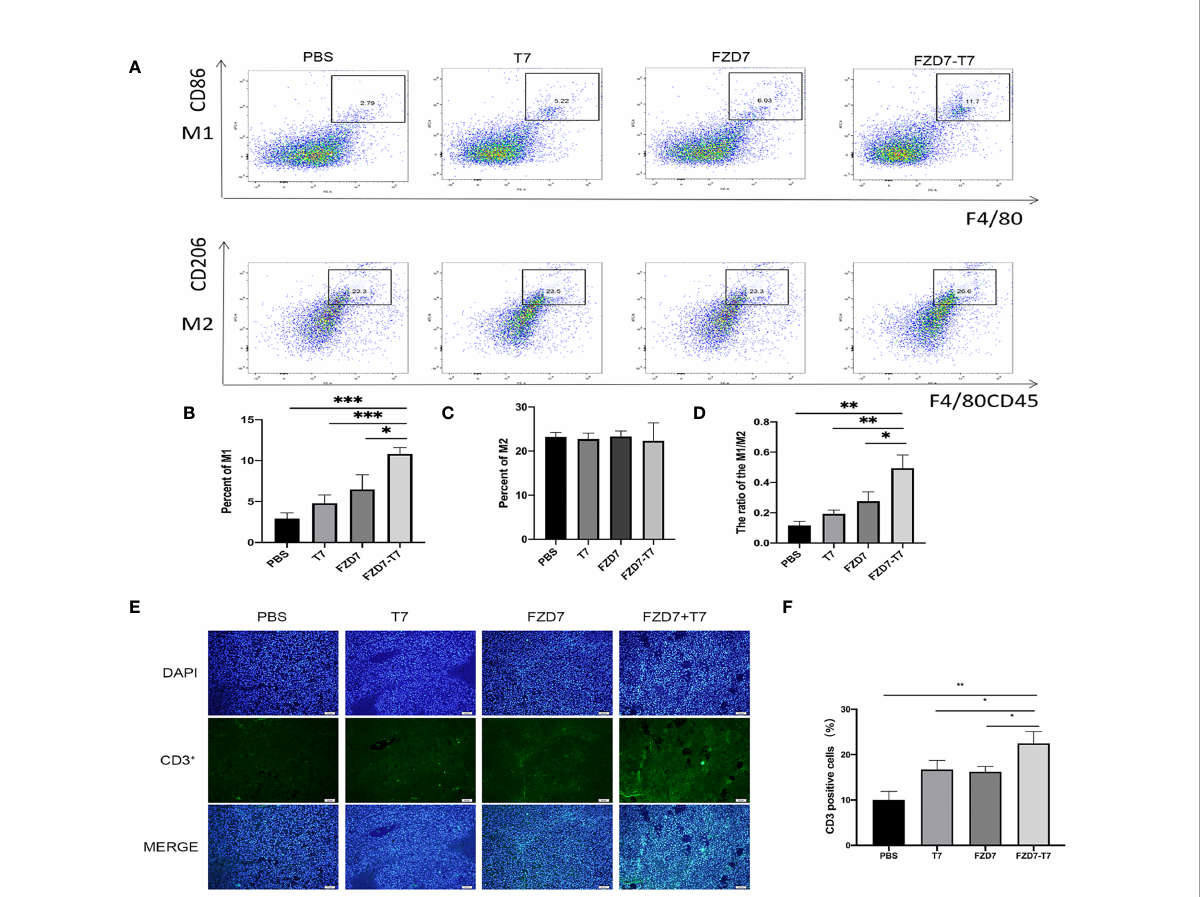
FIGURE 6 Analyze Tumor microenvironment. (A) Flow cytometry of TAM cells. (B) percentage of M1 cells. (C) percentage of M2 cells. (D) The ratio of M1/M2. (E) CD3+ immuno fl uorescence sections of tumor tissue. (F) Quantitative analysis of the proportion of CD3+ T cells in tumor tissues. * P < 0.05, ** P < 0.01, *** P <